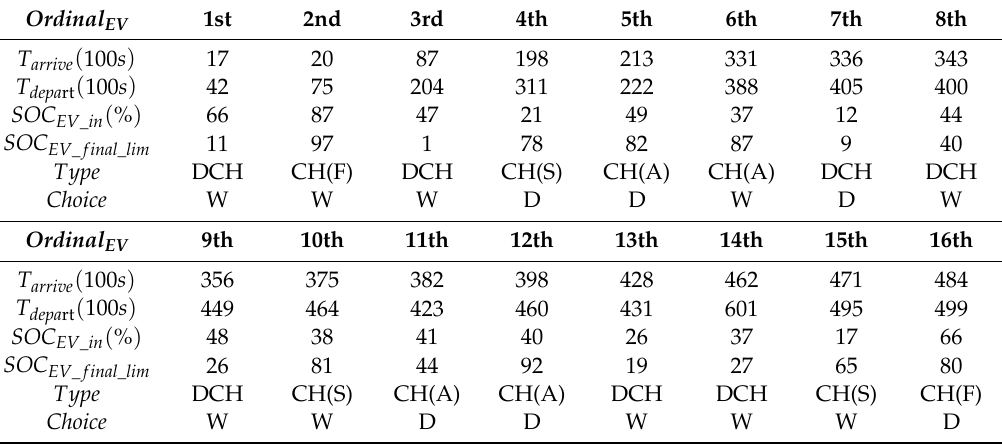
Table 3. Simulation parameters of EVs. CH: charge, DCH: discharge, F: fast mode, A: average